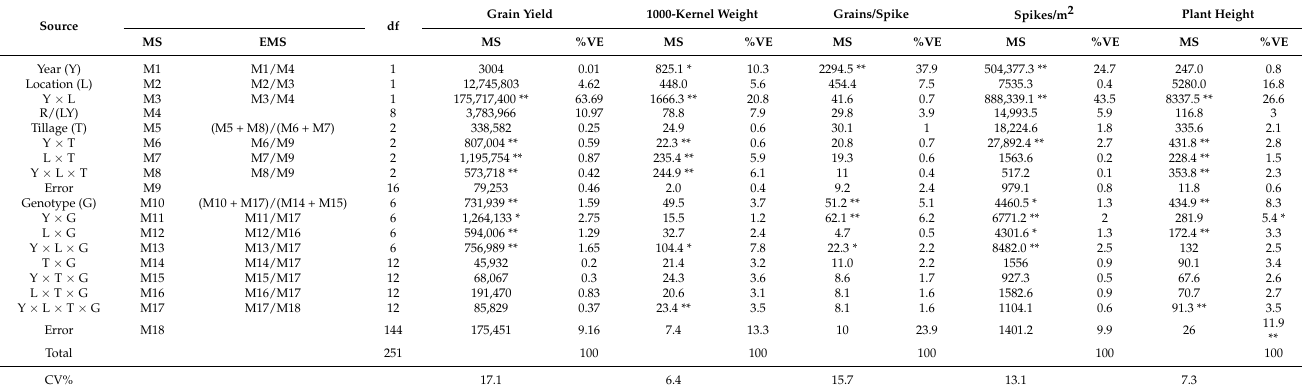
Table 3. Combined analysis of variance for studied traits across tillage, location and